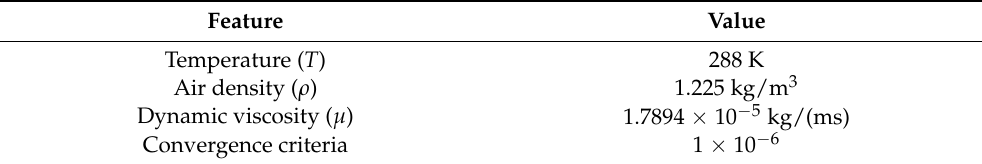
Table 4. Boundary conditions of the numerical simulation.